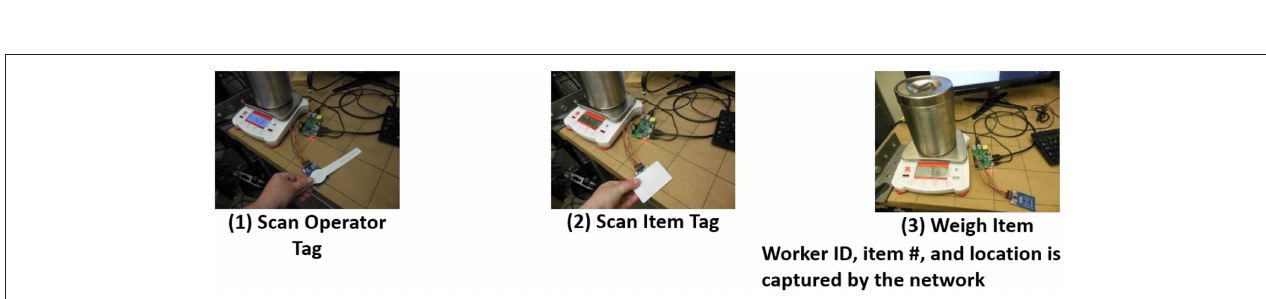
FIGURE 3 | Example showing how a user would interact with the system and the data that is transported on the network as the system is used.